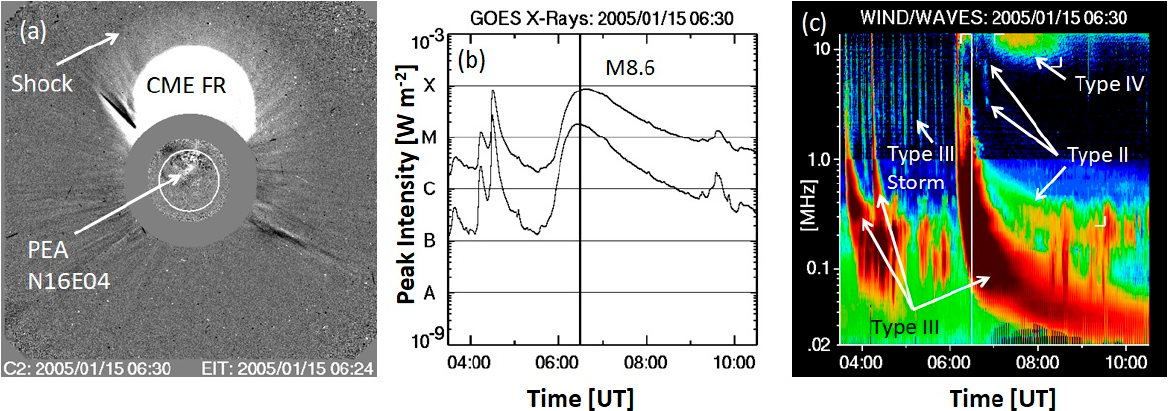
Figure 10. A solar eruptive event and the associated SOHO/LASCO CME ( a ), GOES soft X-ray flare of size M8.6 ( b ), and the radio bursts from the Radio and Plasma Waves experiment (WAVES) on board the Wind spacecraft ( c ). The shock in the CME image is responsible for the type II burst. The type IV burst is from the PEA. The large number of short duration bursts constitute the type III storm in ( c ). The main eruption type III burst (after 06:00 UT) and two earlier isolated type III bursts are indicated. The storm disappears after the eruption type III burst. The vertical line in the GOES plot shows the time of the CME image.